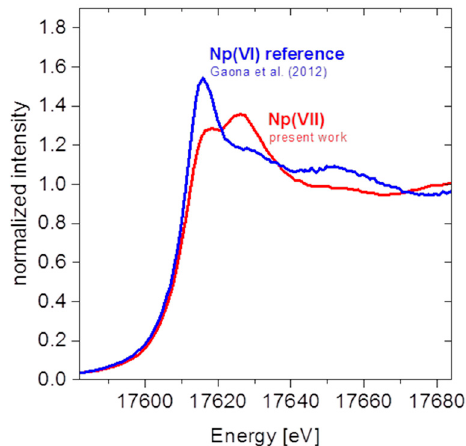
Figure 4. Np L3-XANES spectra of the supernatant solution investigated in this work (2.0 M NaOH + 3.0 M NaCl), compared to the XANES reference spectra reported in [10] for Np(VI) aqueous species in alkaline conditions.